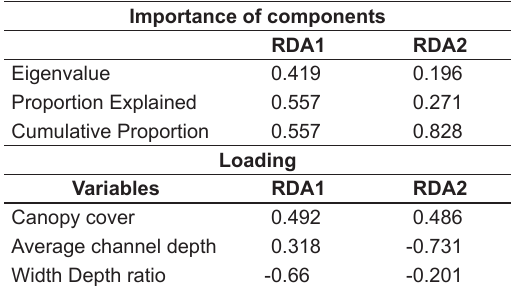
Figure 2. Redundancy analysis of environmental variables and Cladocera communities in Xingu River basin streams in the Cerrado-Amazon ecotone. Green circles are streams surrounded by remnants of native forest and black circles are streams surrounded by cropland. Table 4. Redundancy Analysis (RDA)